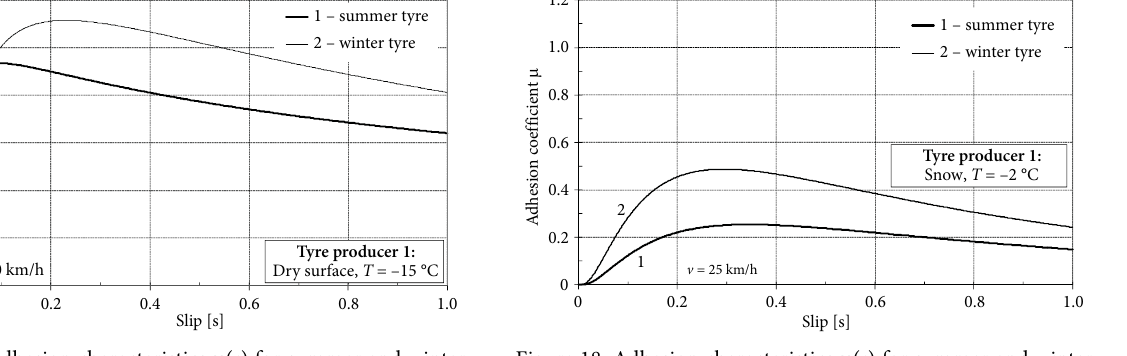
Figure 18. Adhesion characteristics m ( s ) for summer and winter tyres (snowy road surface, tyre producer 1)